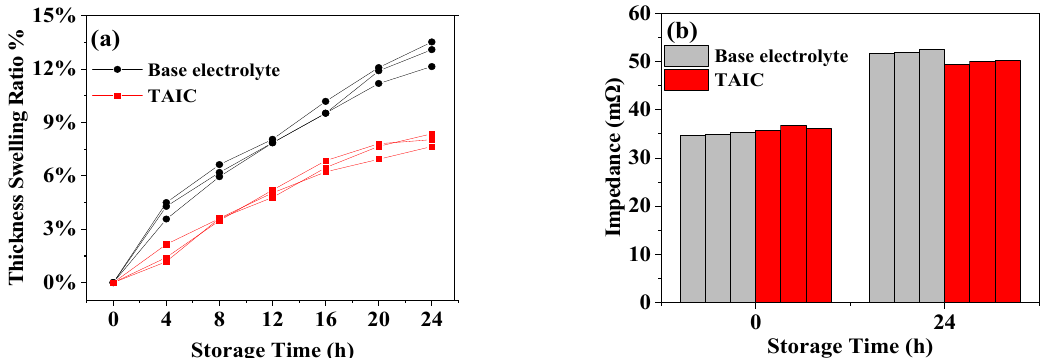
Figure 4. The full-cell storage performance of 85 at °C: ( a ) Thickness swelling; ( b ) Variation in impedance.